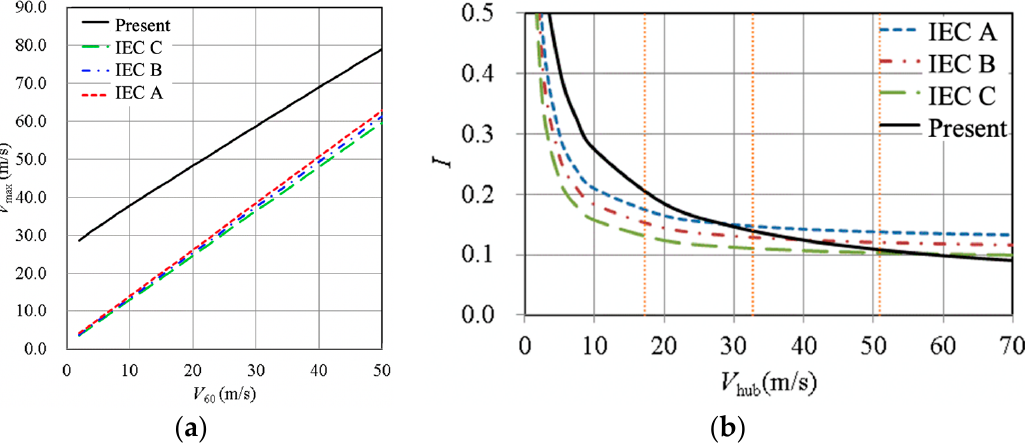
Figure 6. Extreme value analysis during typhoons. ( a ) Gust factor; ( b ) turbulence intensity. Figure 7. Wind condition comparison between local statistics and design standard. ( a ) Gust factor; ( b ) turbulence intensity.